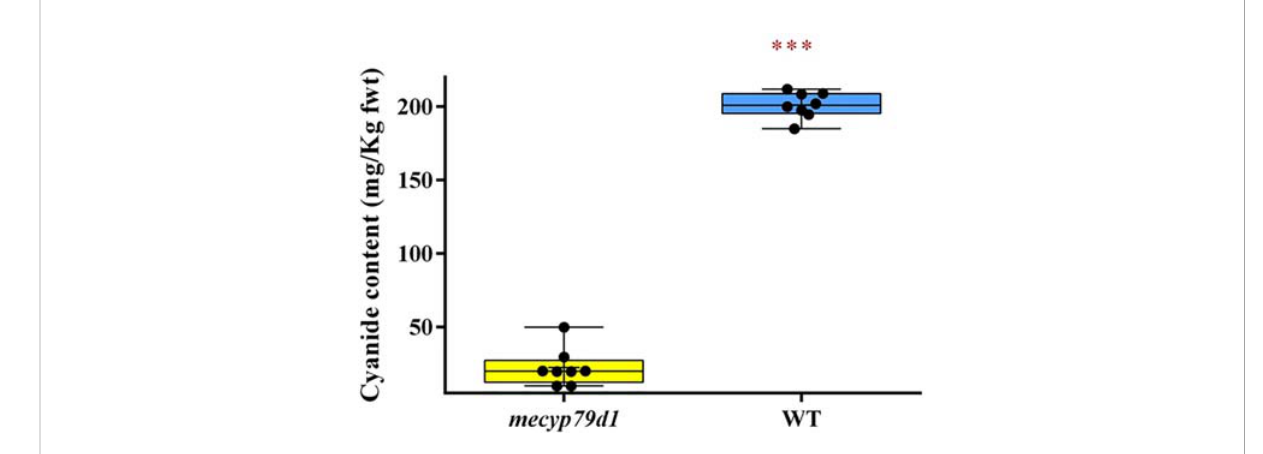
FIGURE 4 Total cyanide content in fresh cassava leaves. Asterisk indicates statistically signi fi cant difference at p<0.05). fwt (fresh